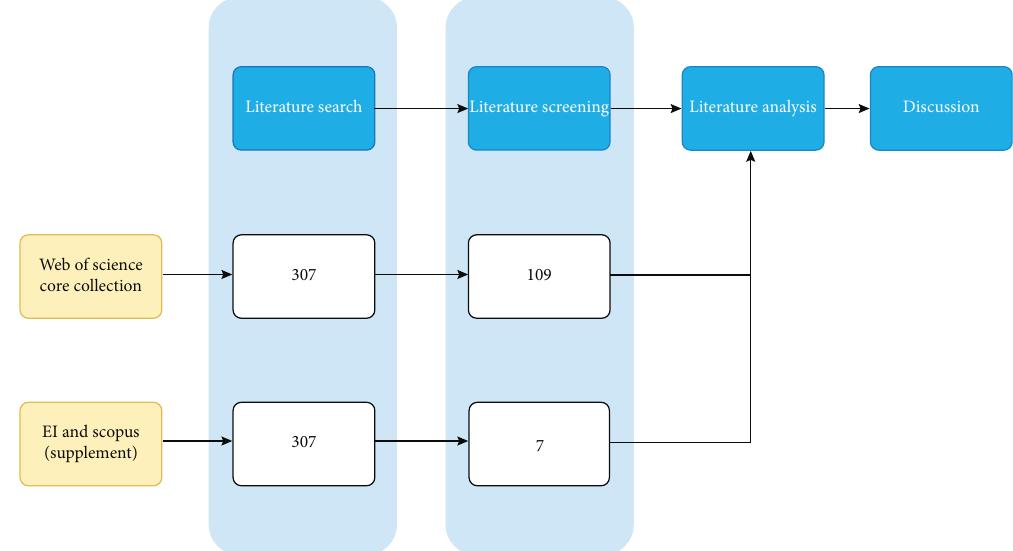
Figure 4: The procedure of literature